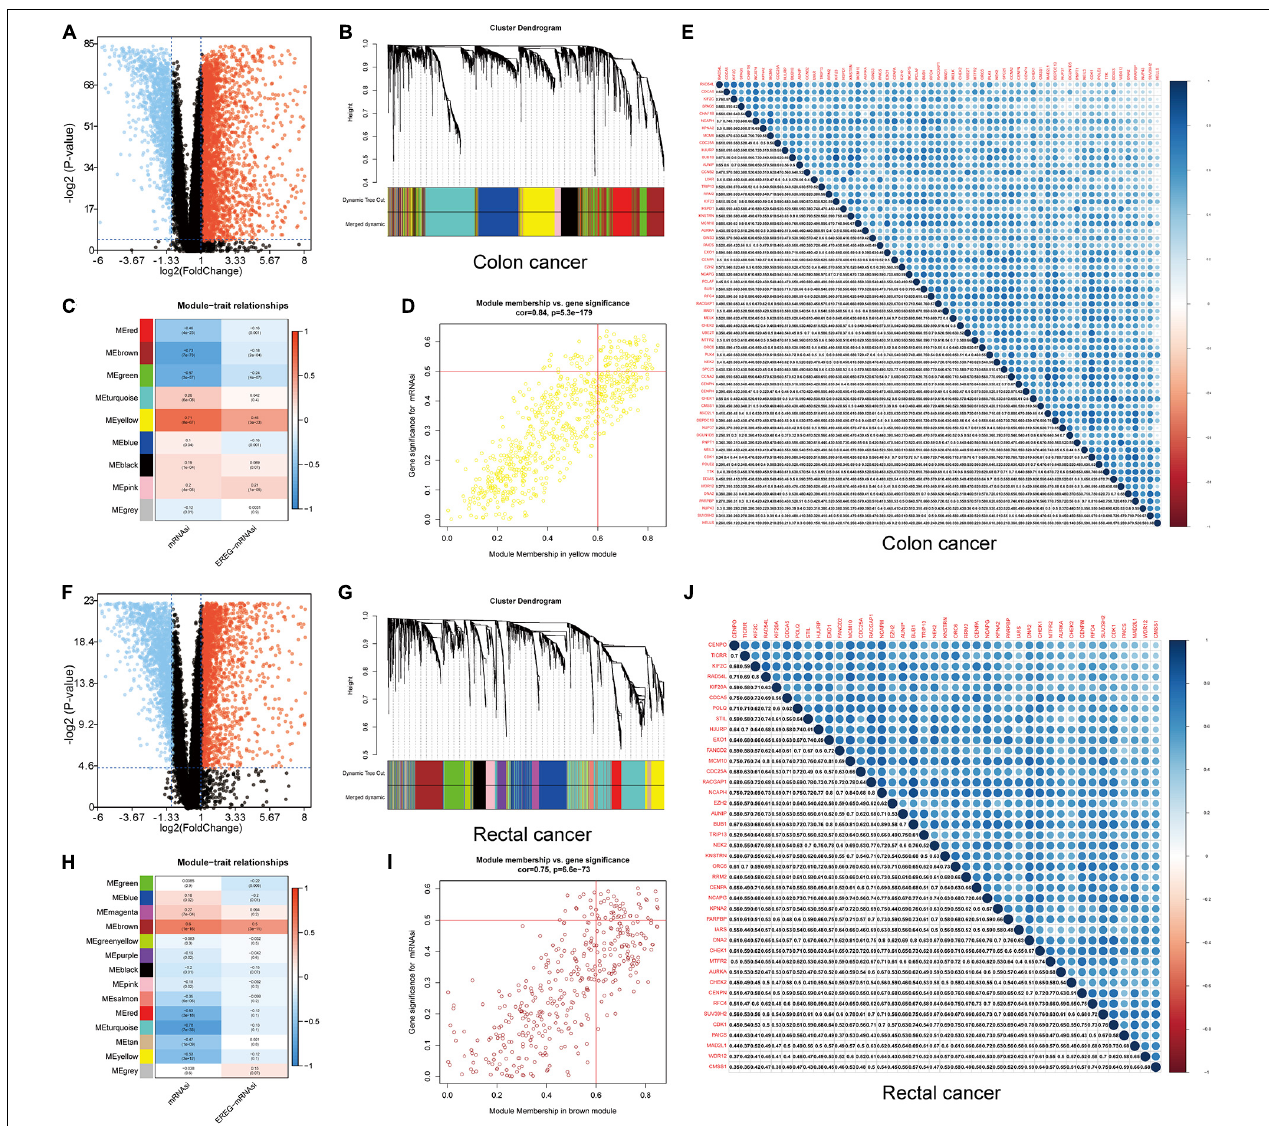
FIGURE 4 | Identification of DEGs and stemness-related key modules in colon and rectal cancer. (A,F) Differentially expressed genes: red indicates upregulated genes, blue indicates downregulated genes, and black indicates genes excluded by DEG screening criteria. (B,C,G,H) Identification of a co-expression module in colon and rectal cancer. Each piece of the leaves on the cluster dendrogram corresponded to a gene, and those genes with similar expression patterns compose a branch. Correlation between gene modules and mRNAsi scores or EREG-mRNAsi. The upper row in each cell indicates the correlation coefficient ranging from -1 to 1 of the correlation between a certain gene module and mRNAsi or EREG-mRNAsi. The lower row in each cell indicates the p -value. (D,I) The scatter plot of the top three important gene modules, and those circles located in the upper right indicate the key genes in these modules. (E,J) Heatmap showing the correlation between stemness-related genes of colon and rectal cancer cases. The shade of each tiny color box represented the corresponding correlation value between two